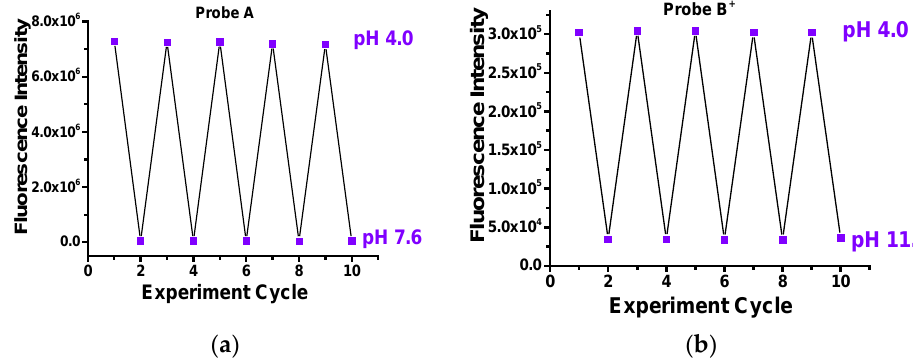
Figure 4. Fluorescence intensities of probes A ( a ) and B + ( b ) in different pH conditions under 450 nm excitation for probe B + , and 550 nm excitation for probe A .